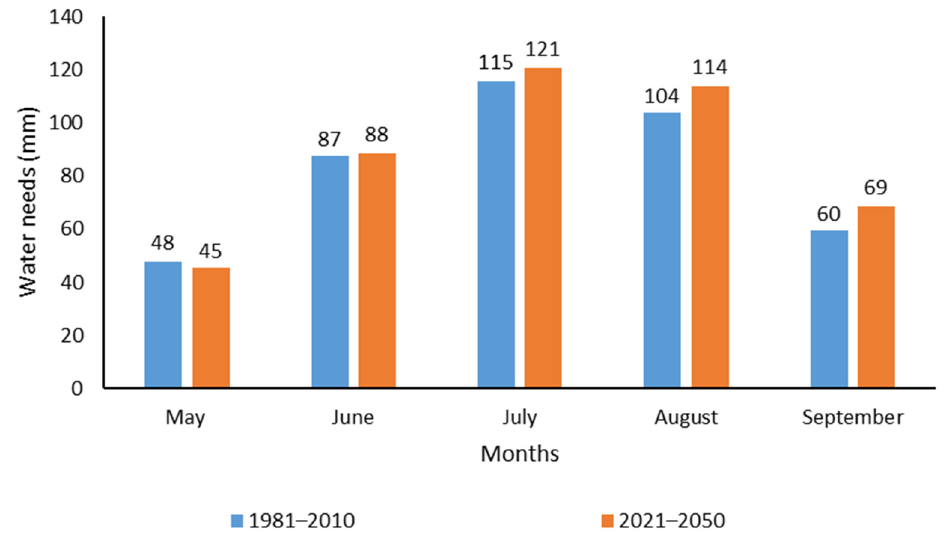
Figure 5. Monthly water needs of grapevines during the growing season in the reference years (1981–2010) and in the forecast years (2021–2050).